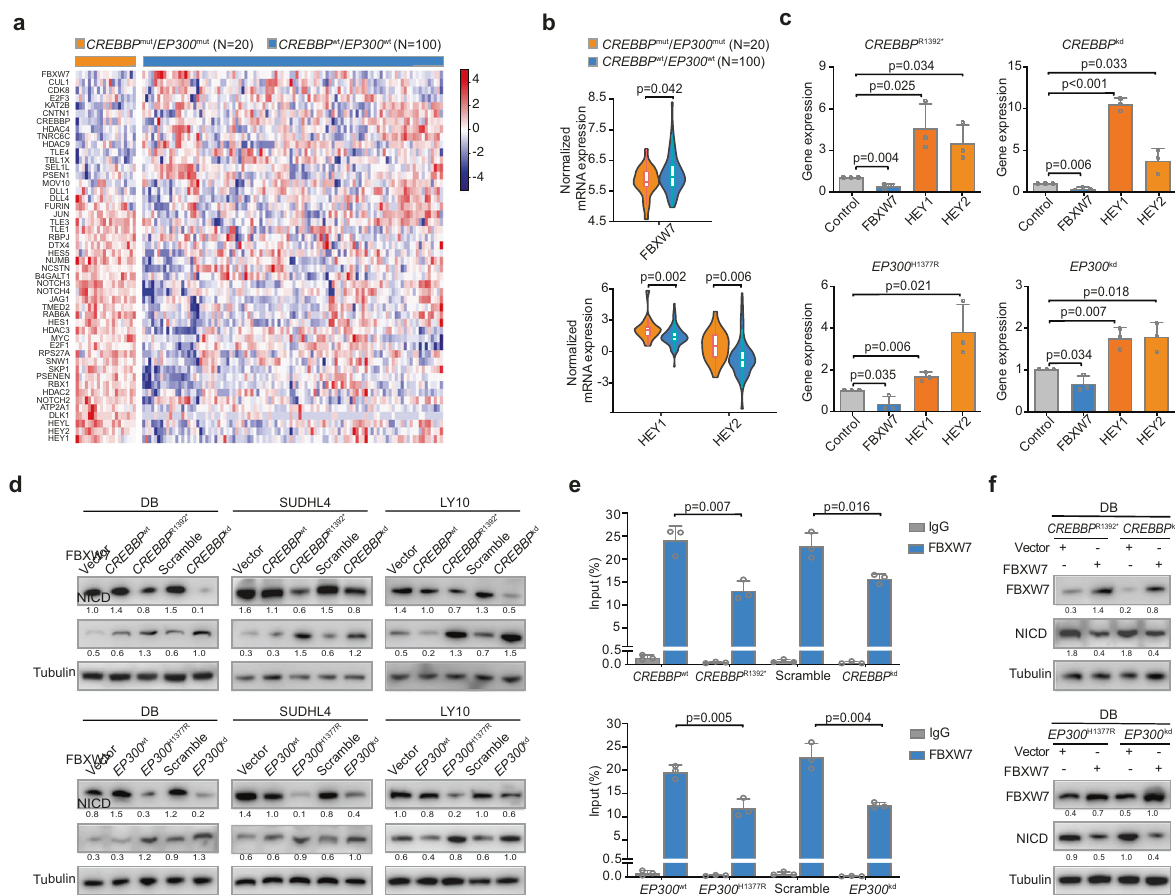
Fig. 4 CREBBP/EP300 mutations inhibited FBXW7 and activated the NOTCH signaling pathway. a Heatmap of genes associated with the NOTCH signaling pathway in CREBBP mut / EP300 mut patients, as compared to CREBBP wt / EP300 wt patients. b Normalized mRNA expression of FBXW7, HEY1 and HEY2 in tumor samples of diffuse large B-cell lymphoma (DLBCL) patients with or without CREBBP / EP300 mutations as revealed by RNA sequencing data. c Relative gene expression of FBXW7, HEY1, and HEY2 in CREBBP R1392* , CREBBP kd , EP300 H1377R , and EP300 kd DB cells, as compared to CREBBP wt , EP300 wt or scramble DB cells by quantitative real-time PCR (RT-PCR). Data are presented as the mean ± SD ( N = 3). d Protein expression of FBXW7 and NICD detected in vector, CREBBP wt , CREBBP R1392* , scramble, CREBBP kd DB, SUDHL4, and LY10 cells, and in vector, EP300 wt , EP300 H1377R , scramble, EP300 kd DB, SUDHL4 and LY10 cells by western blot. The same lysates were used as in Fig. 3b. Tubulin was used as a loading control. The FBXW7/Tubulin and NICD/tubulin ratio were shown. e Occupancies of H3K27ac in the proximal promoter areas of FBXW7 in CREBBP wt , CREBBP R1392* , scramble, CREBBP kd DB cells, and in EP300 wt , EP300 H1377R , scramble, EP300 kd DB cells by chromatin immunoprecipitation (ChIP) assay. Data are presented as the mean ± SD ( N = 3). f Expression of NICD in CREBBP R1392* and CREBBP kd DB cells, as well as EP300 H1377R and EP300 kd DB cells with or without reintroduction of FBXW7 protein by western blot population-related variants, and mutations from SNPs were system (Roche), and deep sequencing was performed with identi fi ed by COSMIC (the Catalogue Of Somatic Mutations In established Illumina protocols on the GAIIx and MiSeq platform Cancer, version 77). Germline mutations detected from control (Illumina) following the manufacturer ’ s instructions. samples were excluded. Sanger sequencing was used in the The Refseq database (human reference genome version hg19) training cohort and randomly selected in the validation cohort to was used as a reference genome. SAMtools was used to generate con fi rm somatic mutations. None of these mutations was detected chromosomal coordinate-sorted bam fi les and to remove PCR in matched peripheral blood mononuclear cells from patients in duplications. The reads were realigned around potential indel the training cohort. With all CREBBP / EP300 mutations veri fi ed, 70 regions by Genome Analysis Toolkit (GATK) version 3.4 IndelRea- mutations falling outside the HAT domain were validated and ligner with the recommended pipeline. The WGS depth of each con fi rmed as somatic mutations. sample was over 30×, and WES depth was about 120×. The Copy number analysis of WGS and WES samples were targeted sequencing depth of each sample was about 1000×. For conducted with CNVkit using the batch pipeline recommended paired and unpaired samples, variants were required to have a in the CNVkit manual (https://cnvkit.readthedocs.io/en/stable/ minimum coverage of 10× counting only reads with a base quality pipeline.html). 50 Speci fi cally, sequencing reads were mapped to over 20 and mapping quality over 30. The variant allele frequency (VAF) of tumor mutations was over 10% (at least three reads of human reference sequence GRCh37 using BWA (version 0.7.17) support), and the cutoff of VAF used in paired normal DNA was and deduplicated using Picard (version 2.23.3). Then sequen- 8%. 49 SNVs and indels were called using GATK Haplotype Caller cing depth pro fi le was corrected using GATK (version 4.0.0) best-practice pipeline with respect to GC-content, capture and GATK Uni fi ed Genotyper and were mapped to the genome target size and regions containing sequence repeats. The location using the UCSC Genome Browser (http://genome.ucsc. abundance of aligned reads to each region were compared edu/) for annotation. In total, 1000 Genome variants eliminated Signal Transduction and Targeted Therapy (2021)